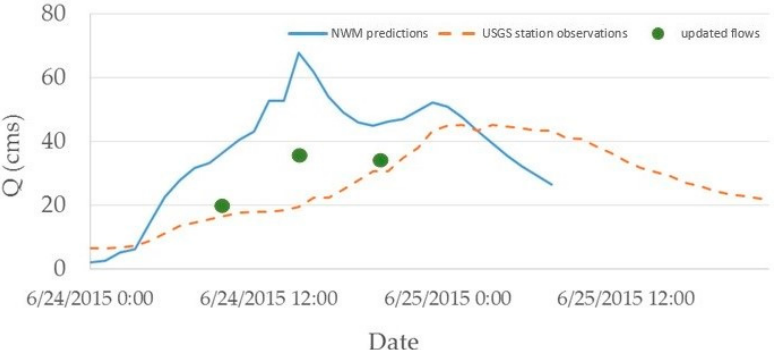
Figure 5. River flow at a USGS station at Squaw Creek at Ames. Solid blue line shows the NWM predictions, dashed ‐ red line shows the observations at the USGS station, and green dots show the updated flows.